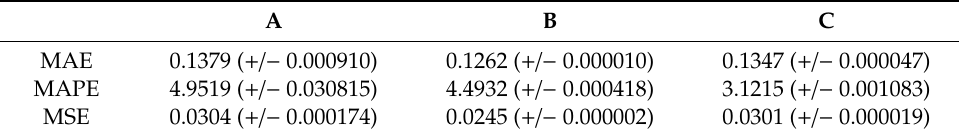
Table 7. GBRT model performance using the test set data.